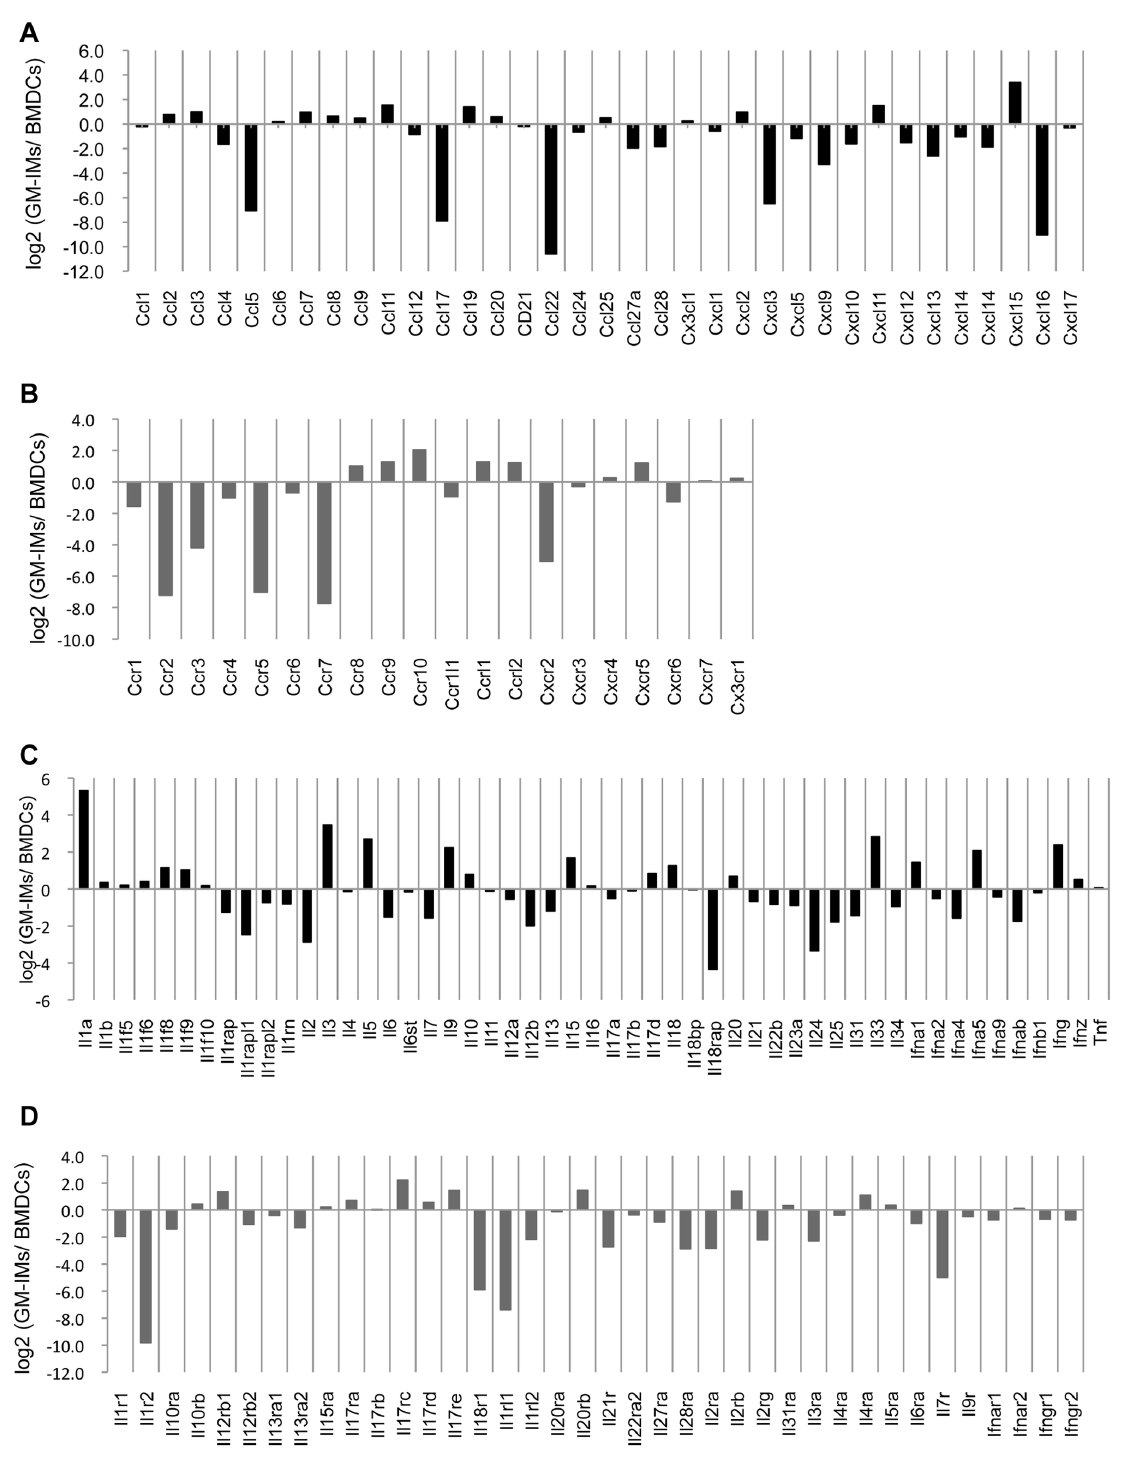
Figure 3. Gene expression profiles of GM-IMs compared to BMDCs. Comparison of gene expression levels between ten months cultured GM-IMs and BMDCs cultured for six days, both in 10% GM-CSF-CM. They were analyzed with a GeneChip mouse genome 430 2.0 microarray. (A) Relative chemokine expression of GM-IMs compared to BMDCs. (B-D) Relative chemokine receptor (B), cytokine (C) and cytokine receptor (D) expression, as in (A). doi: 10.1371/journal.pone.0076943.g003 PLOS ONE |